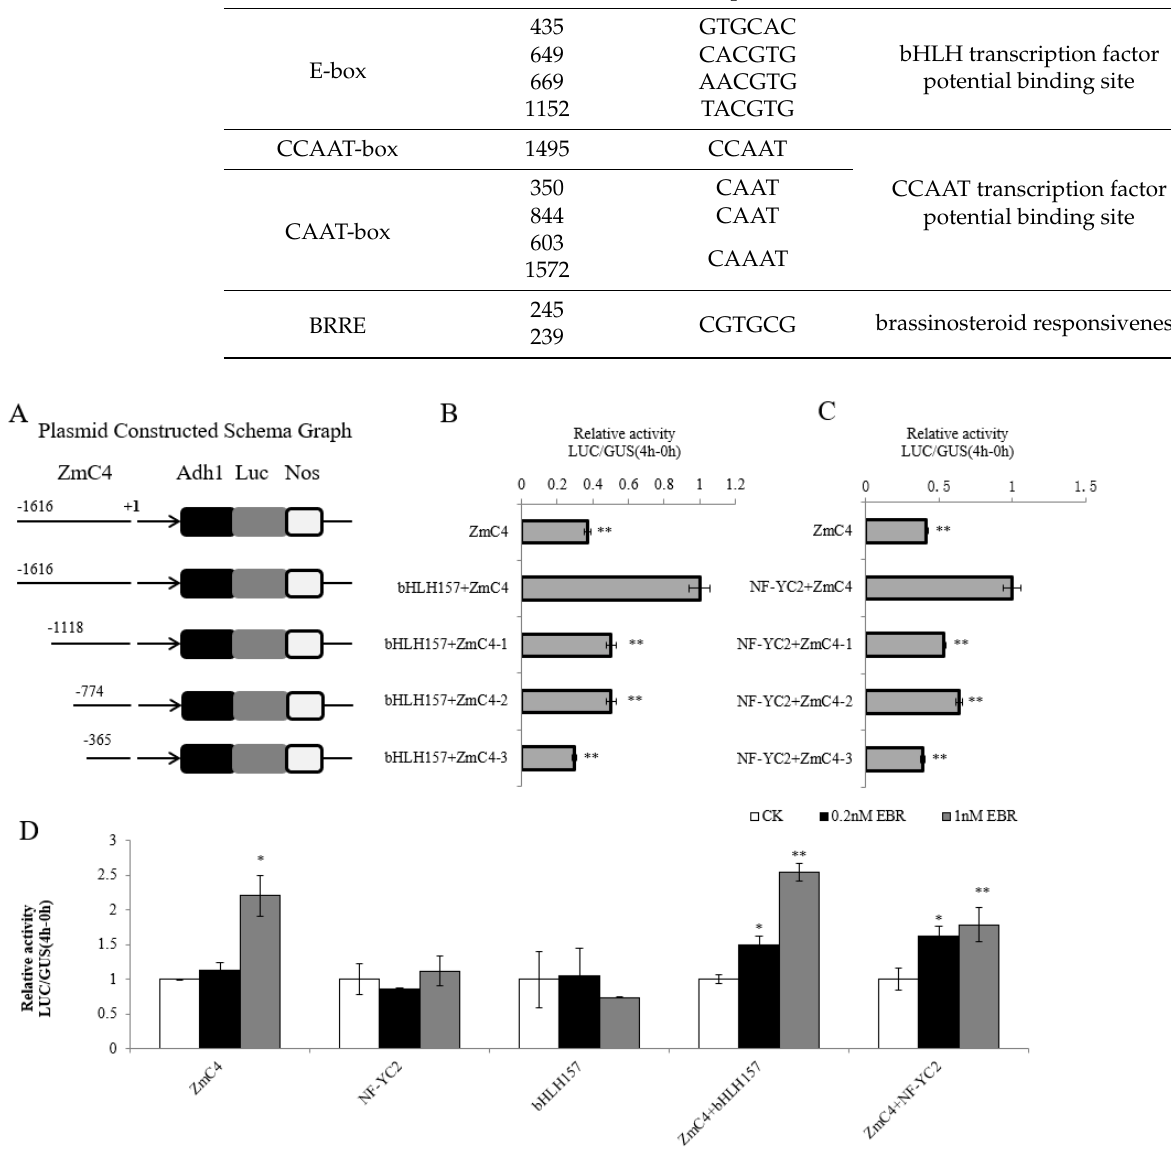
Figure 5. Preliminary exploration of interaction regions between ZmbHLH157/ZmNF-YC2 and ZmC4 promoter. ( A ) Schematic diagram of the construction of a promoter fragment deletion vector. ( B ) Relative activity of LUC after co-transformation of ZmbHLH157 with promoters of different lengths. ( C ) Relative activity of LUC after co-transformation of ZmNF-YC2 with promoters of different lengths. ( D ) Relative activity of LUC after EBL processing transcription factor transient overexpression of protoplasts. “*” represented as p < 0.05, “**” represented as p < 0.01.